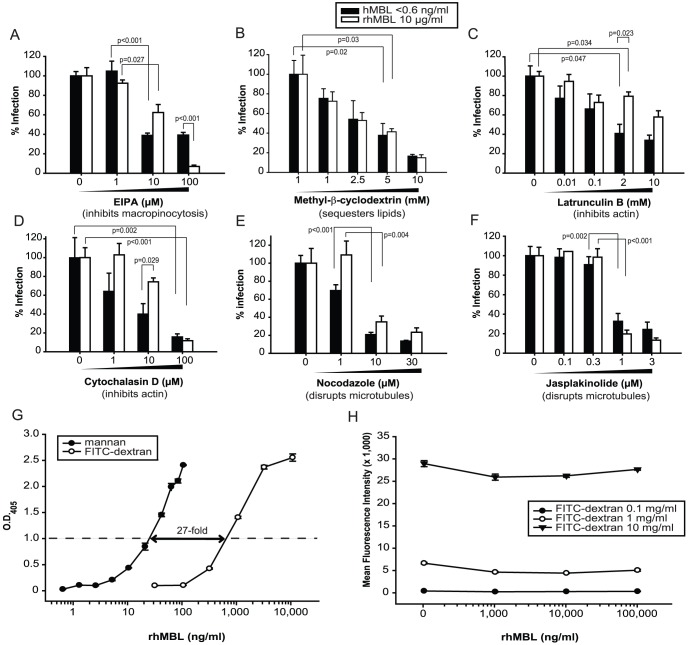
MBL mediates HIV-EBOV GP infection via the canonical macropinocytosis pathway for EBOV but with less dependence on actin.We preincubated HEK293F cells with (A) EIPA (5-(N-Ethyl-N-isopropyl)amiloride, a potent and specific inhibitor of Na+/H+ exchanger activity), (B) methyl-β-cyclodextrin (extracts or sequesters cholesterol from the plasma membrane), (C) latrunculin B (blocks actin polymerization), (D) cytochalasin D (inhibits actin microfilament function), (E) nocodazole (disrupts microtubules), or (F) jasplakinolide (disrupts microtubules) in 5% MBL-deficient serum in the absence or presence of rhMBL at 37°C for 1 hour. We then infected cells with HIV-EBOV-GP virion-like particles (1200 pg p24/100 µl). Percentages of infected cells are relative to DMSO controls. Luciferase values were adjusted for cell viability. Experiments were performed twice in quadruplicate. Significant differences are shown. (G) Absorbance values of an ELISA assay are shown indicating the difference in amount of rhMBL within the physiological range that binds to immobilized mannan or FITC-dextran (1 µg/100 µl). (H) We preincubated FITC-dextran with various concentrations of rhMBL at 37°C for 30 minutes and then added the products to PMA-stimulated (10 ng/ml), IL-4-supplemented (100 ng/ml) THP-1 cells at 37°C for 1 hour. We measured FITC-dextran uptake by flow cytometry and reported the results as mean fluorescence intensity (geometric mean fluorescence × percentage of cells). Experiments were performed twice in triplicate.